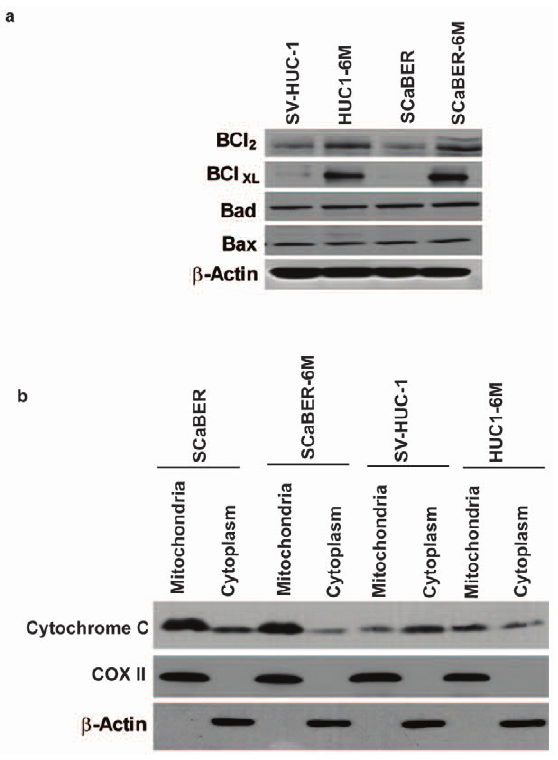
Figure 6. CSC vapor induces Survival Proteins. (a) Cellular lysates were obtained from the indicated cell lines and subjected to Western Blot analysis using the indicated antibodies. b -actin was used as a control. (b) The indicated cell lines were treated with 3 m g/ml cisplatin for 48 h. Mitochondrial and cytoplasmic total cellular lysates were subjected to Western Blot analysis using anti-cytochrome c antibody. Protein extracts in each lane are as indicated. Immunodetection of aˆ- actin and COX II were done to assure that the transfected proteins were in cytoplasm and mitochondria respectively.